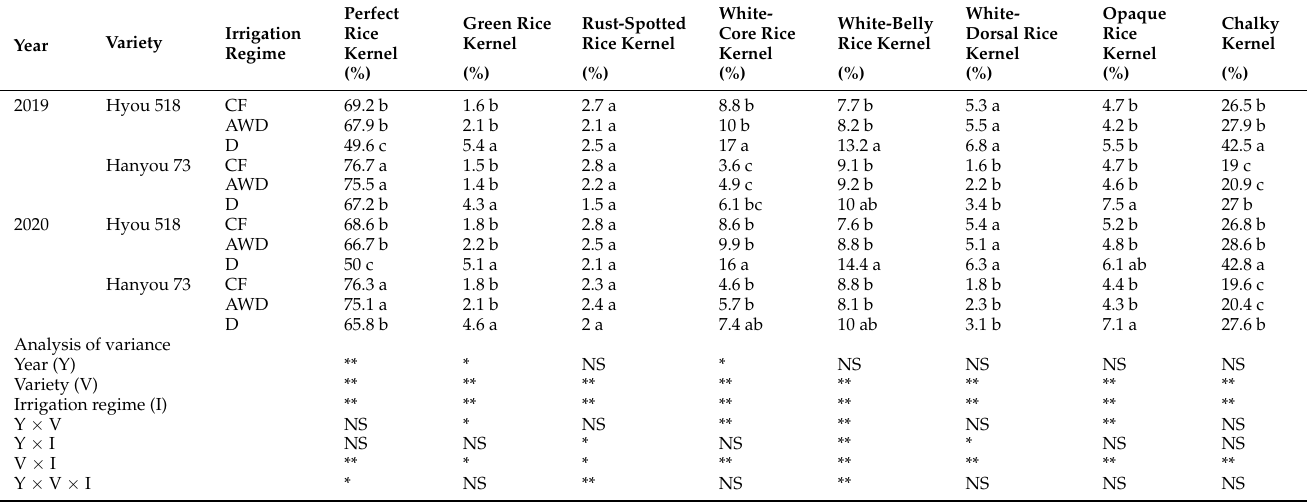
Table 2. Appearance quality under various irrigation